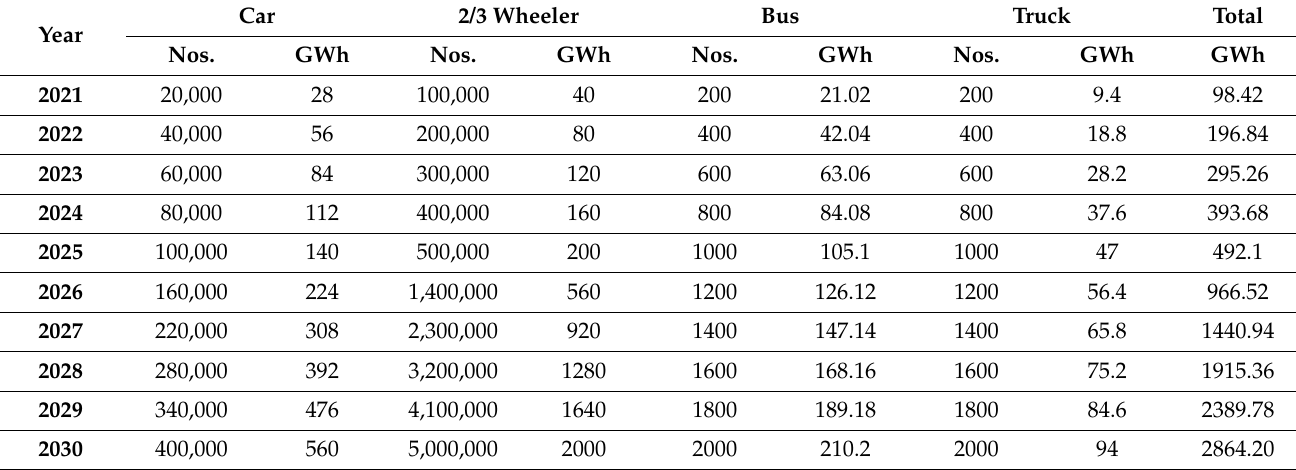
Table 3. EV electricity consumption: 2021–2030.